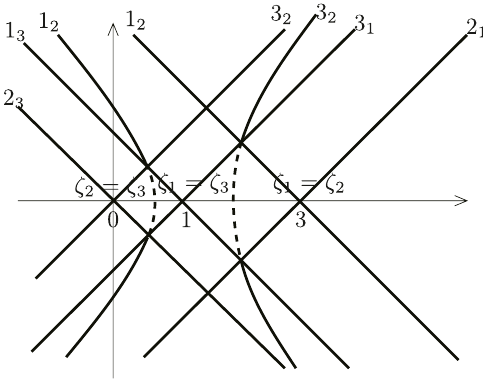
Figure 6 . Unlike the NBR model, each level crossing gives the (degenerated) MTP structure, from which four Stokes lines are coming